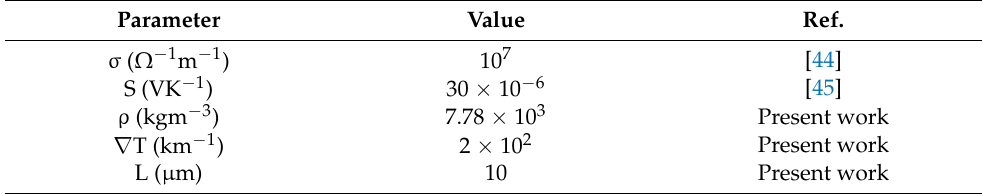
Table 4. Physical properties of the Co-Ni-Al alloy.